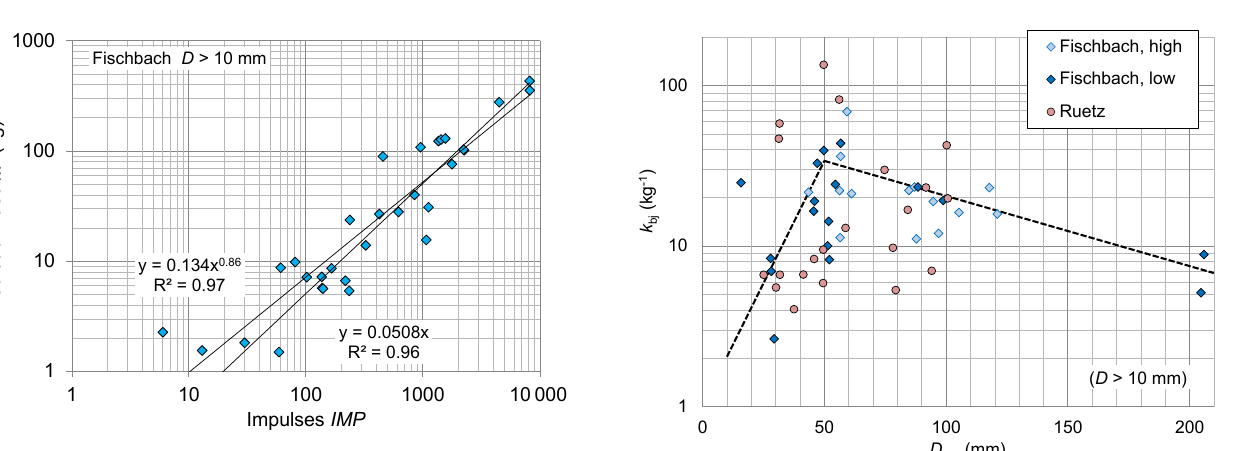
Figure 7. Linear calibration coefficient k bj vs. characteristic grain size D 84 , determined for particles with D > 10mm. Fischbach: data points marked “high” and “low” refer to impulse rates higher and lower than 1 (0.5 − 1 m − 1 s − 1 ), respectively. The dashed lines are meant to guide the